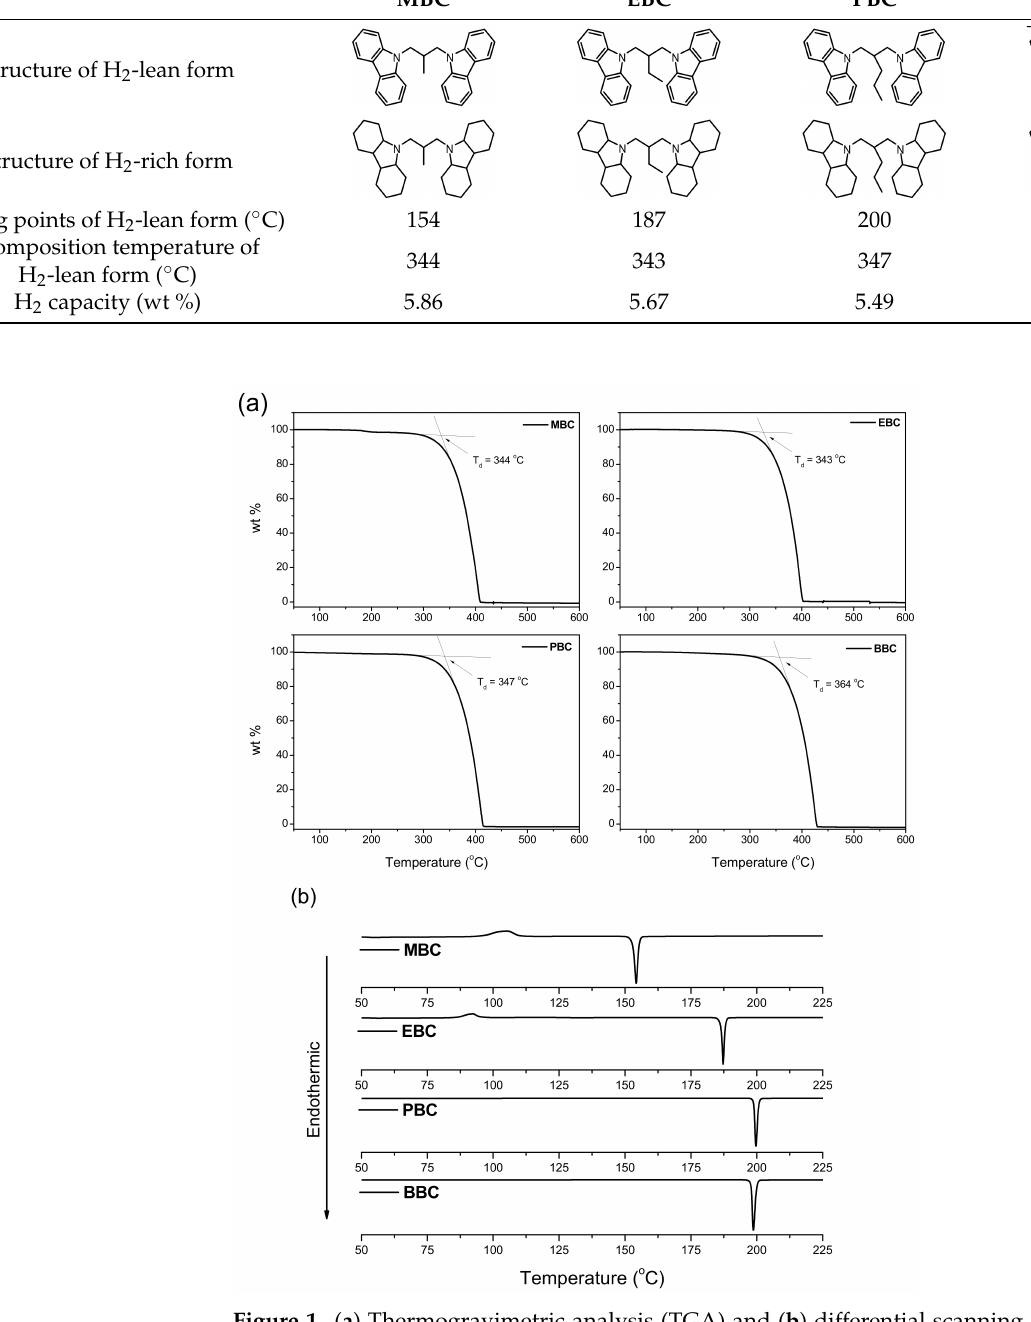
Figure 1. ( a ) Thermogravimetric analysis (TGA) and ( b ) differential scanning calorimetry (DSC) diagrams for MBC , EBC , PBC , and BBC